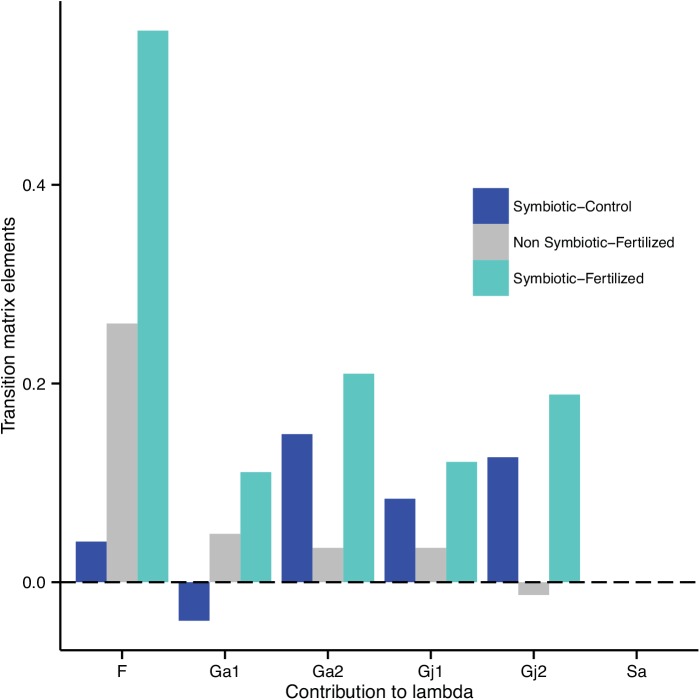
Contributions of matrix elements to the variability of λ for Festuca eskia populations, as a function of endophytic status and edaphic resource level.